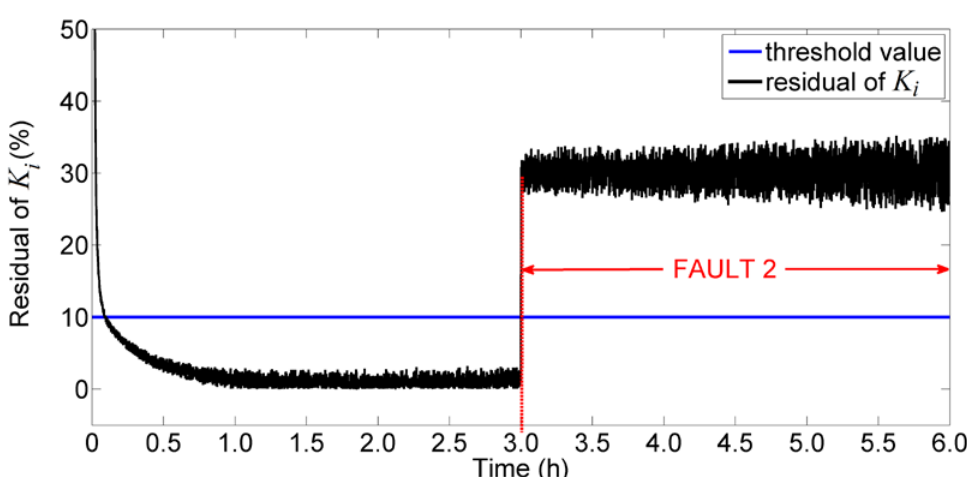
K for faulty scenario 2. i